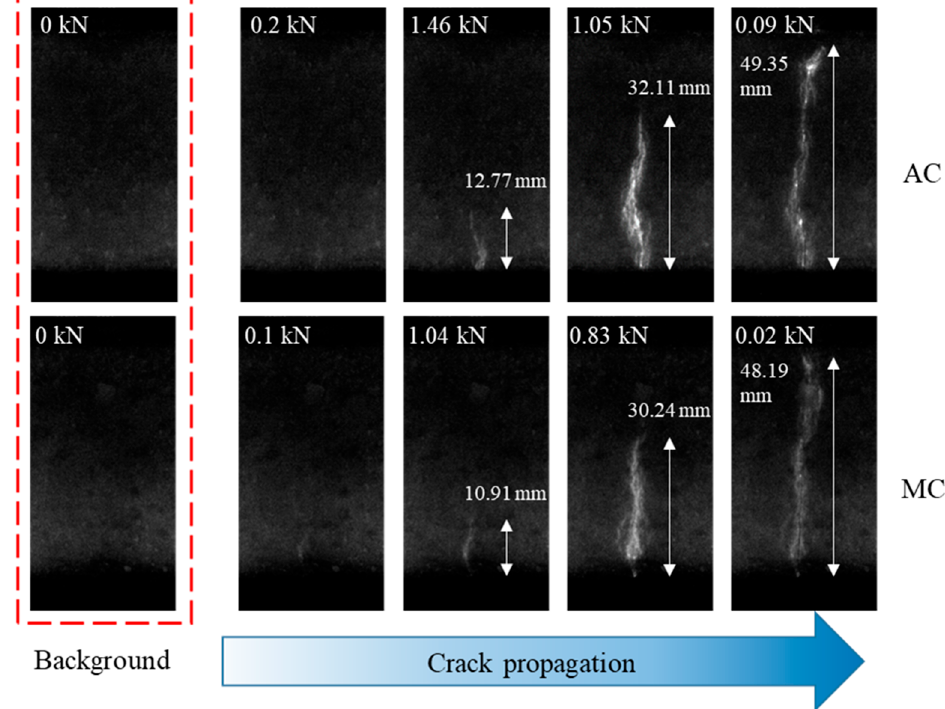
Figure 3. Sequential ML gray images illustrating crack initiation and propagation in AC and MC during SENB testing, which were recorded using a high-speed camera at a frame speed of 250 frames/s .